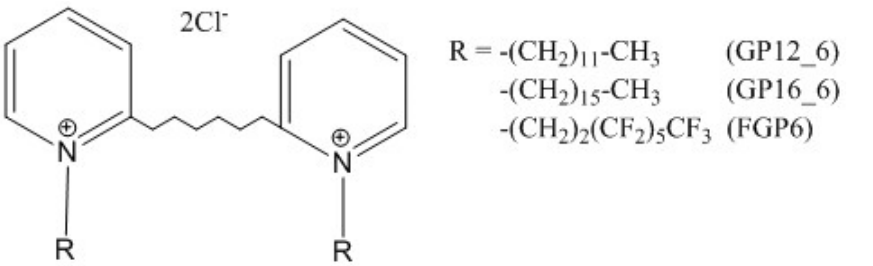
Figure 9. Chemical structure of the compounds under study with spacer six methylene